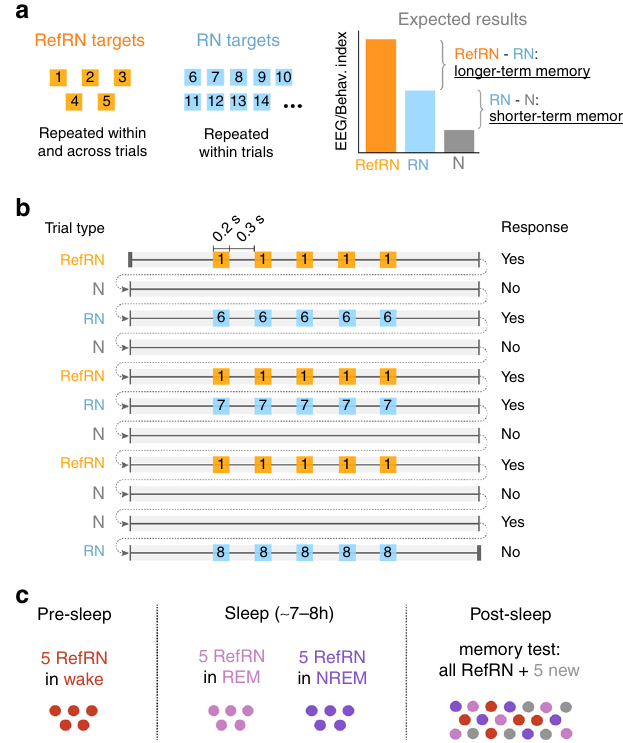
Fig. 1 Noise memory paradigm in wakefulness and sleep. a , b Stimuli and expected results: Participants ( N = 20) were instructed to discriminate between trials made of running white noise (N) and trials that contained a repeated pattern (RN and RefRN), made by the seamless concatenation of short (0.2 s) noise segments (targets) interleaved with 0.3 s fresh white- noise fi llers. RN (within-trial repetition) and RefRN (within- and across-trial repetition) trials had an identical structure and differed only regarding the amount of exposure to the target. Participants ’ ability to discriminate RN from N trials evidences shorter-term memory for the novel repeated target. A better discrimination for RefRN compared to RN trials additionally indicates longer-term memory processes ( a , right ). c Full-night recording : . Each recording session started with a pre-sleep phase, during which participants were instructed to remain awake. In all, 5 unique